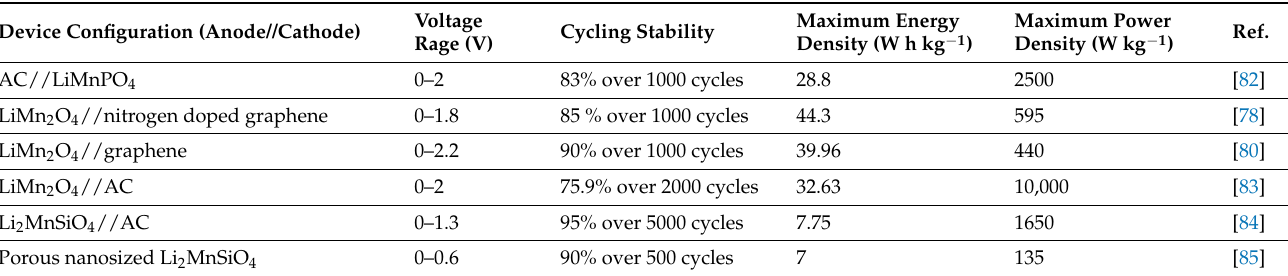
Table 2. Lithiated manganese-based material LIC